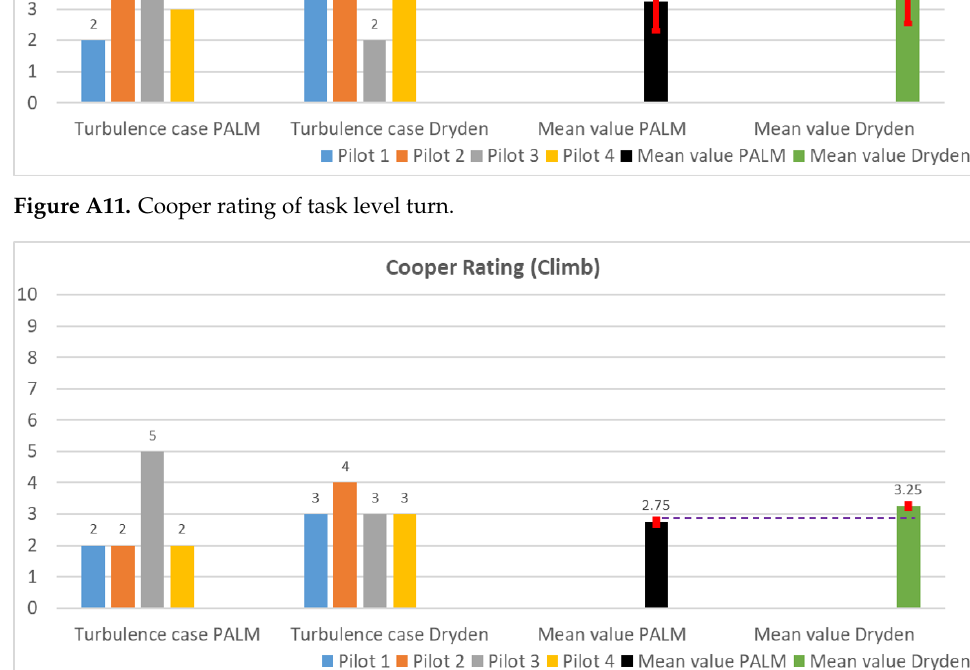
Figure A12. Cooper rating of task